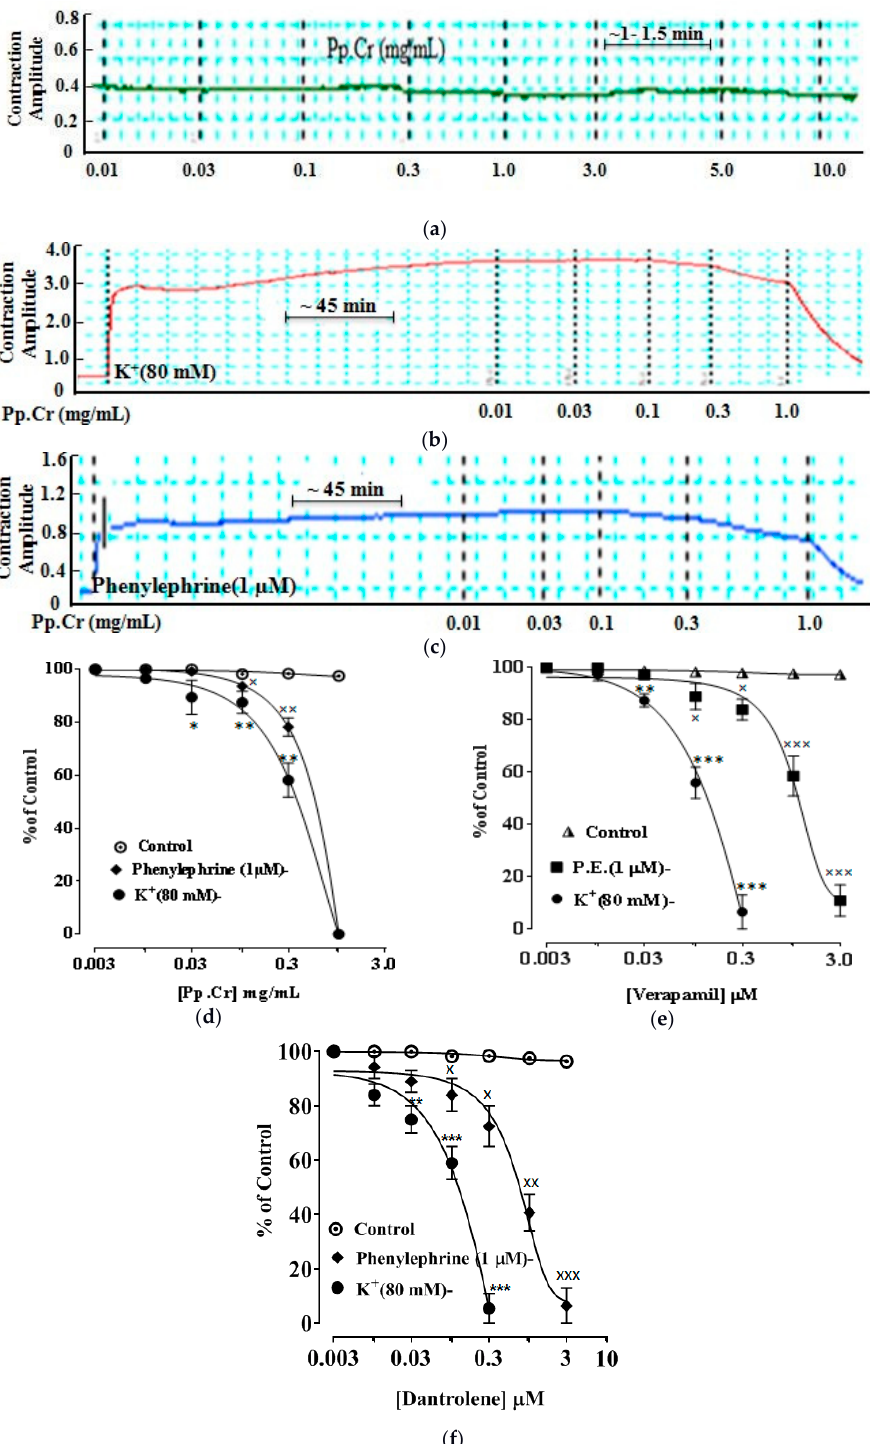
Figure 7. Tracing showing the effect of Pp.Cr (mg/mL) on un-stimulated rabbit aortic preparation as control ( a ). Concentration-response curves showing inhibitory effect of Pp.Cr (mg/mL) ( b – d ), verapamil (µM) ( e ) and dantrolene (µM) ( f ) against K + (80 mM)- and phenylephrine (1 µM)-induced aortic contractions. * p < 0.05, ** p < 0.01, and *** p < 0.001 compares the effects of various conc. of Pp.Cr (mg/mL) on K + (80 mM)-induced aortic contractions. × p < 0.05, ×× p < 0.01, and ××× p < 0.001 compares the effects of various conc. of Pp.Cr (mg/mL) on phenylephrine (1 µM)-induced aortic contractions. (Mean ± SEM, n = 5).